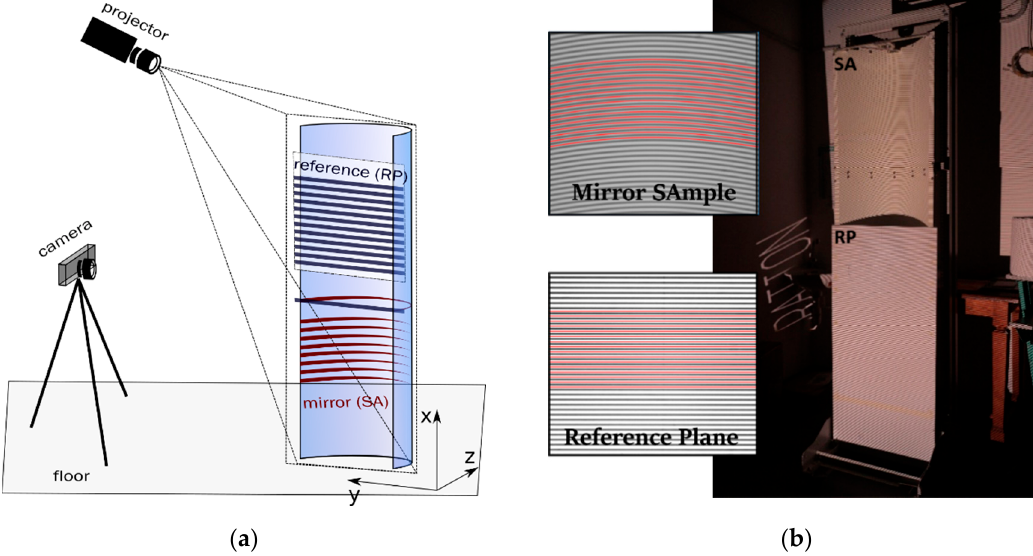
Figure 4. Example of structured light profilometry: ( a ) schemes of the approach and ( b ) geometry of projection and vision systems.